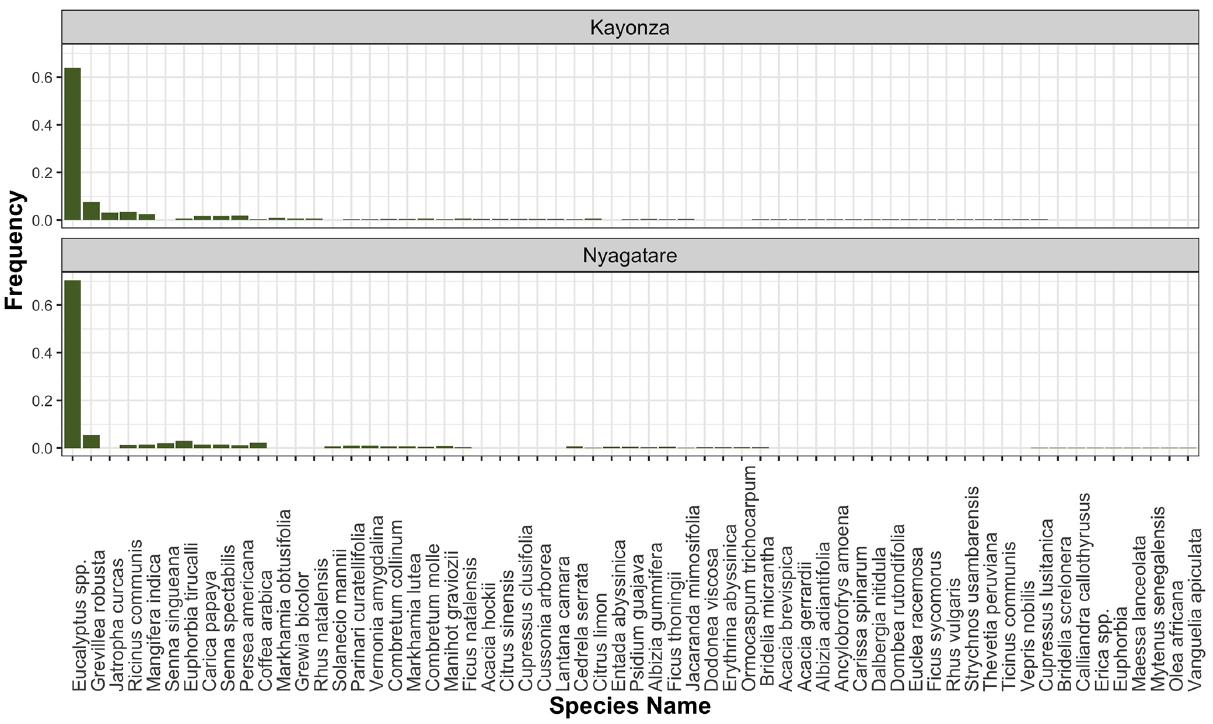
Figure 2. Tree species across the Kayonza and Nyagatare LDSF sites, Rwanda. Sixty-two different species were recorded, with low occur- rence of most species and few indigenous tree species.